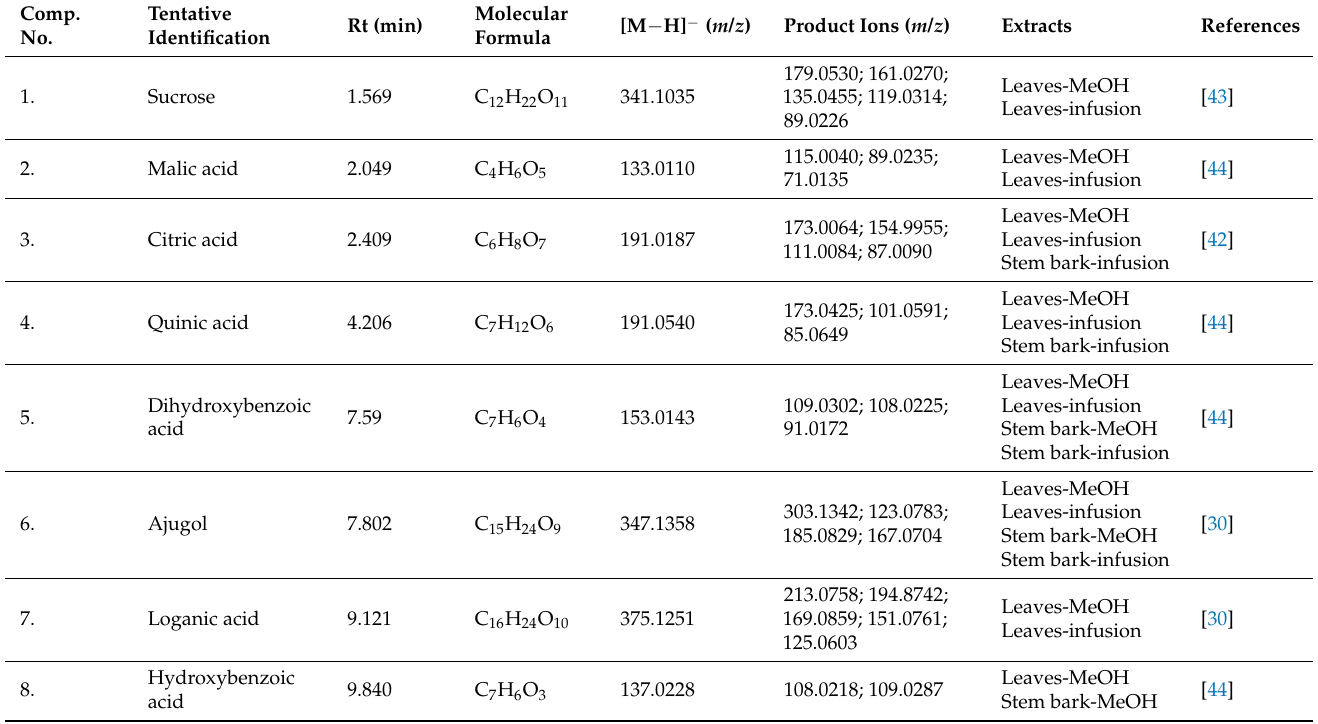
Table 2. Spectral characteristics of compounds present in the studied